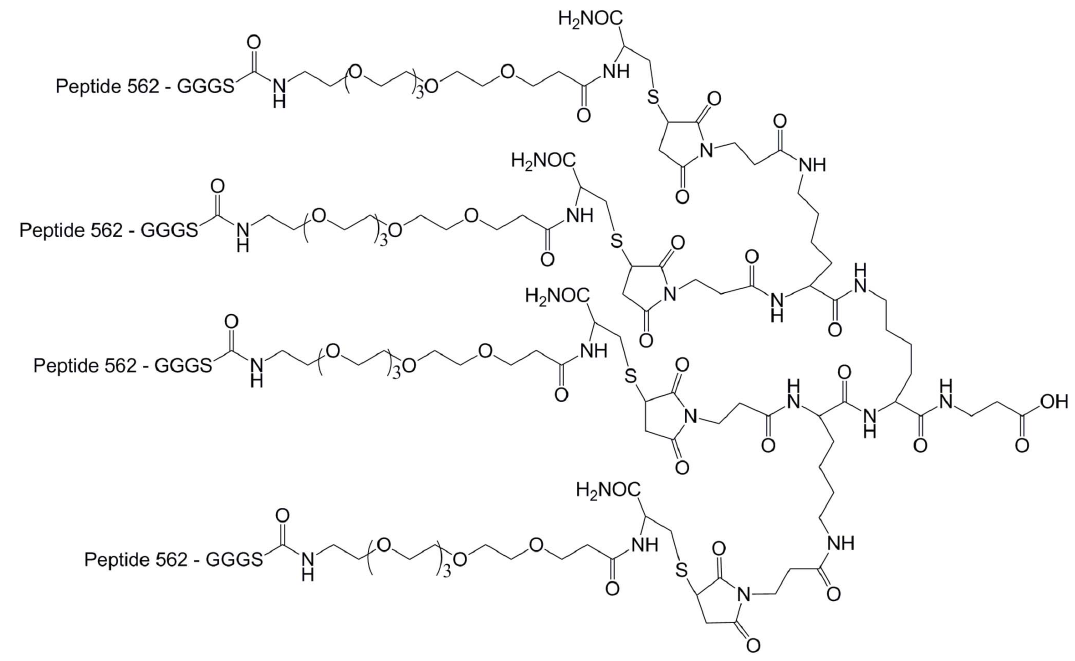
Figure 6. Structure of the Peptide 562 tetramer.